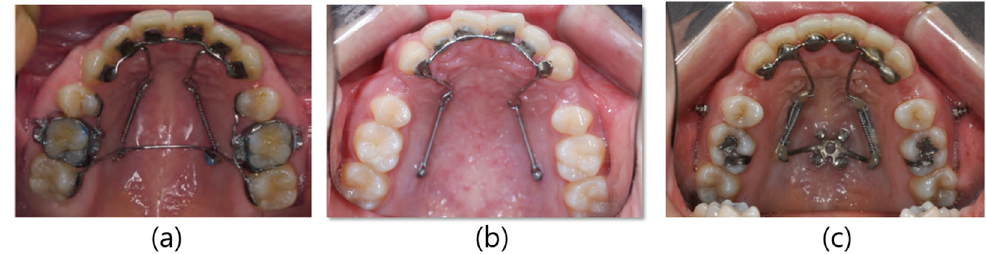
Figure 2. Modifications of the C-lingual retractor (CLR): ( a ) lever arms positioned between both central and lateral incisors, and TPA between both first molars; ( b ) lever arms on both canines, and miniscrews on palatal slope; ( c ) lever arms positioned between both central and lateral incisor, and C-palatal plate.